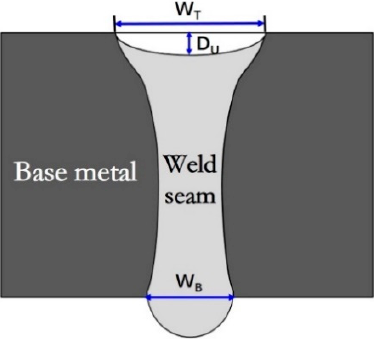
Figure 4. Typical schematic of weld cross-section profile made by single-pass full-penetration welding.